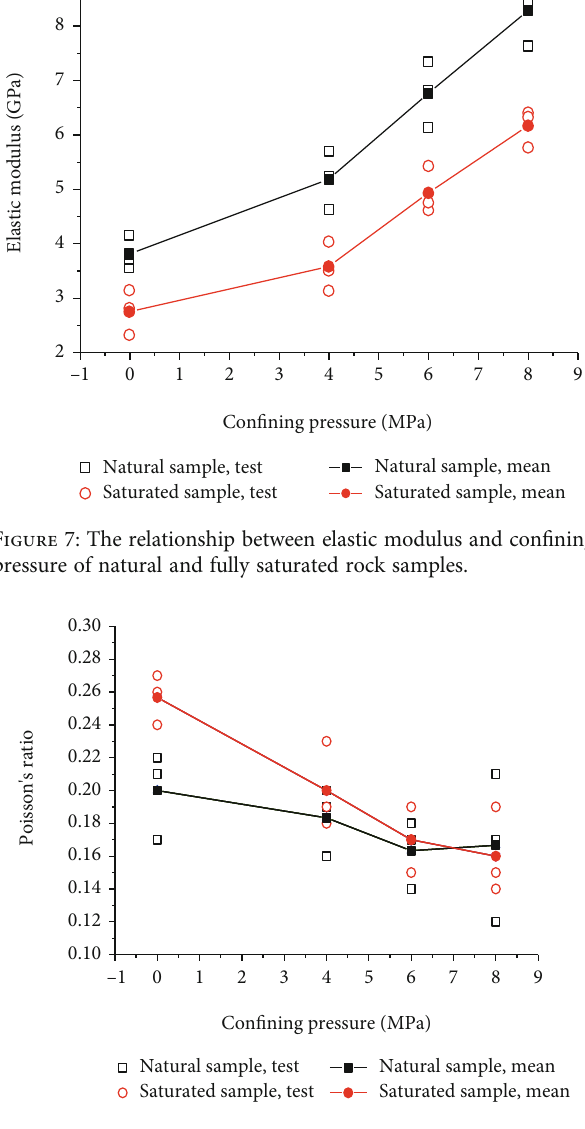
Figure 8: The relationship between Poisson ’ s ratio and con fi ning pressure of natural and water-saturated rock samples.